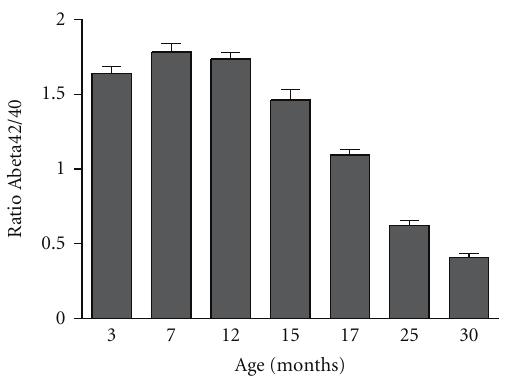
Figure 3: Progression of CSF Abeta42/40 ratios in ageing APP-Ld mice; from the age of 15 months onwards, the ratio of Abeta42/40 in CSF